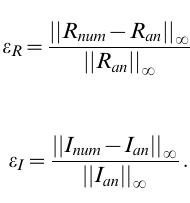
figure 4. We define relative errors in the incident and reflected waves as